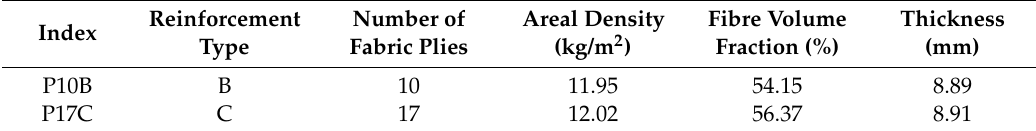
Table 2. Specifications of the designed composite panels.